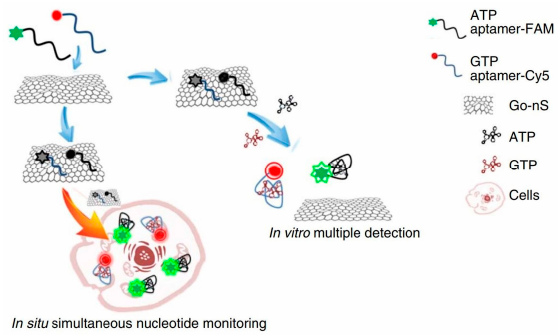
Figure 5. Schematic figure of in vivo and in situ molecular probing in living cells by using the aptamer/GO-nanosheet nanocomplex [79]. When ATP aptamer–FAM and GTP aptamer–Cy5 bind to GO nanosheets, fluorescence is “off” because of the fluorescence-quenching ability of GO. On the other hand, fluorescence is “on” when the aptamers are released into cells. Reproduced from [79]